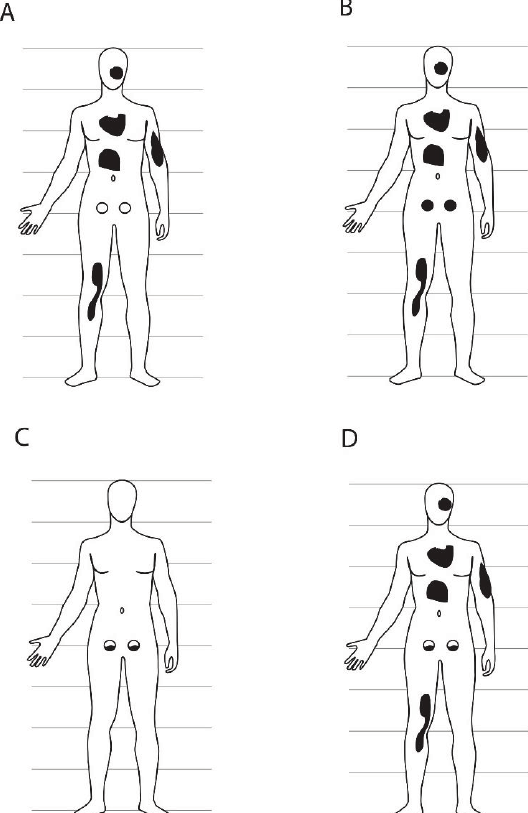
Figure 2. Potential anatomical patterns of mosaicism based on the lineage and mutational scenarios of Figure 1. Each panel is matched to the equivalent panel in Figure 1 (panel A , germ line clonal, mutation in soma; B , germ line clonal, mutation in cell ancestral to germ line and some of soma; C , germ line clonal, mutation in germ line; D , germ line not clonal, mutation in cell ancestral to some of germ line and some of soma). The germ line is presented as two circles in the lower abdomen, either wild type (unshaded) or mutant (black). Patches of somatic tissue carrying a de novo mutation are shown as irregular black shapes and may include skin and/or any other kind of somatic cells. In panels ( C ) and ( D ), germ line mosaicism is shown in both the right and left gonad, but other gonad patterns are likely as well, depending on how the primordial gonads are populated by PGCs. Relative sizes of the germ line versus soma are not to scale; the germ line in humans is obviously much smaller than the soma in physical size and cell number. Patterns of mosaicism are also not meant to be interpreted literally, other than inclusion or exclusion of all or part of germ line versus